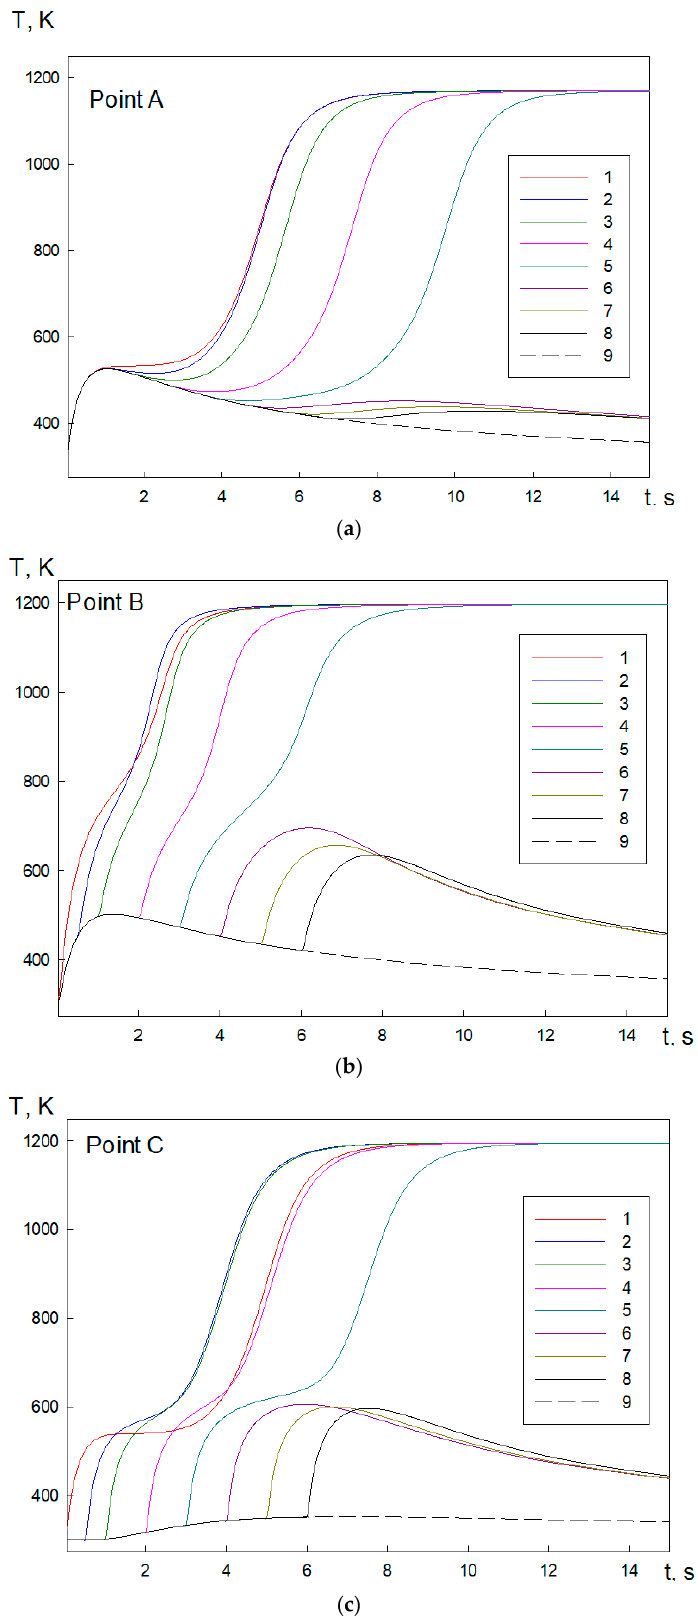
Figure 11. Temperature change over time: L = 49 mm, d = 5.5 mm, h = 6.5 mm, 1— ∆ t = 0, 2—0.5 s,